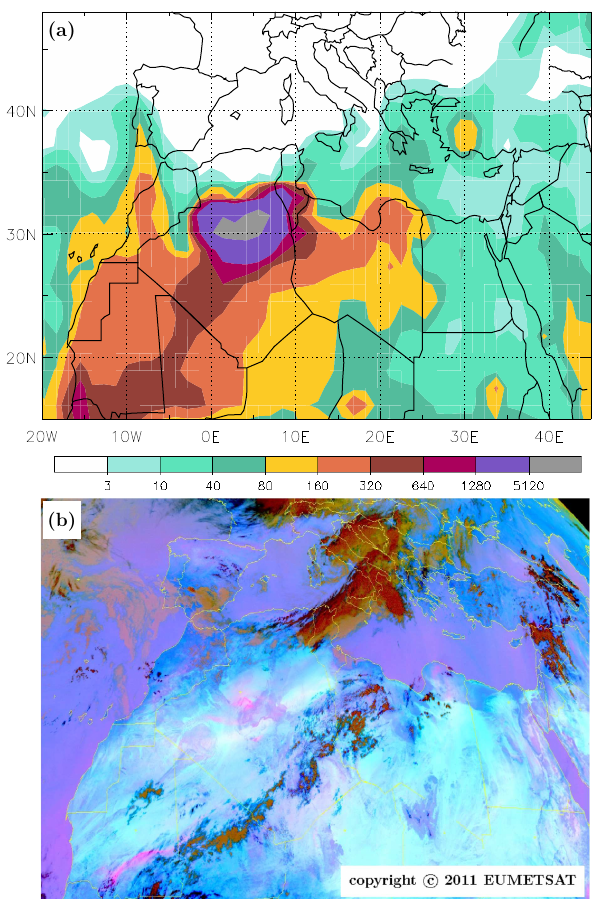
Fig. 6. Dust concentration (µgm − 3 ) on the lowest model layer of EMAC (a) and MSG dust RGB composite (b) on 1 June 2006